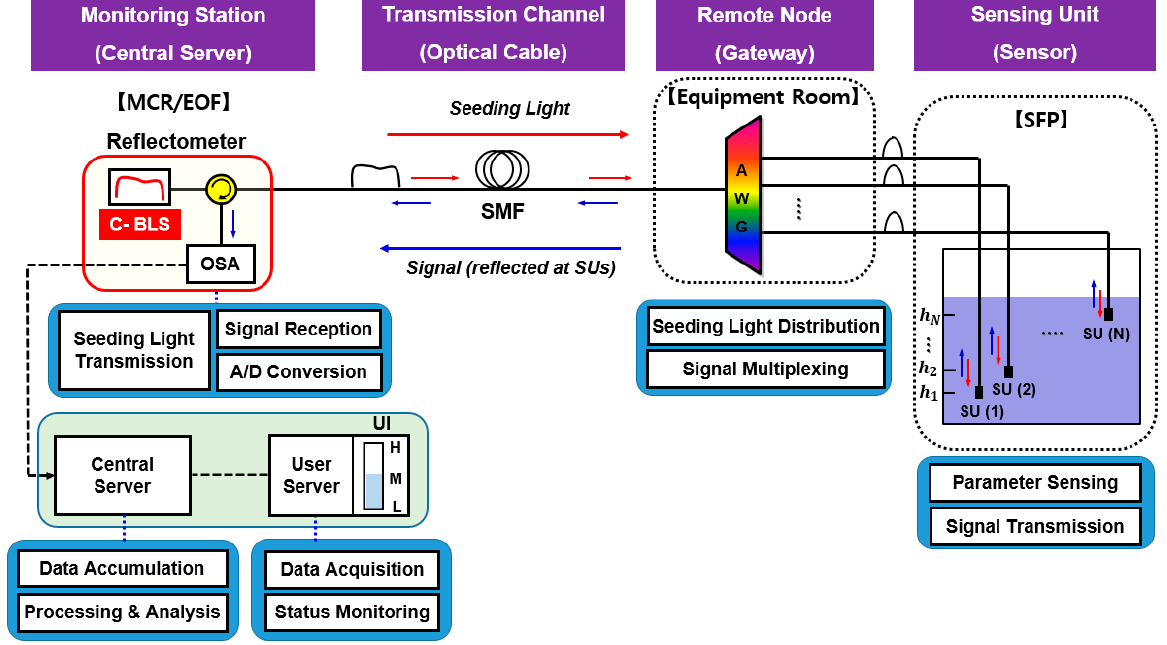
Figure 2. The architecture of a passive IoT optical fiber sensor network for water level monitoring. OSA—Optical Spectrum Analyzer, SMF—Single Mode Fiber, SU—Sensing Unit, MCR—Main Con- trol Room, EOF—Emergency Operation Facility.